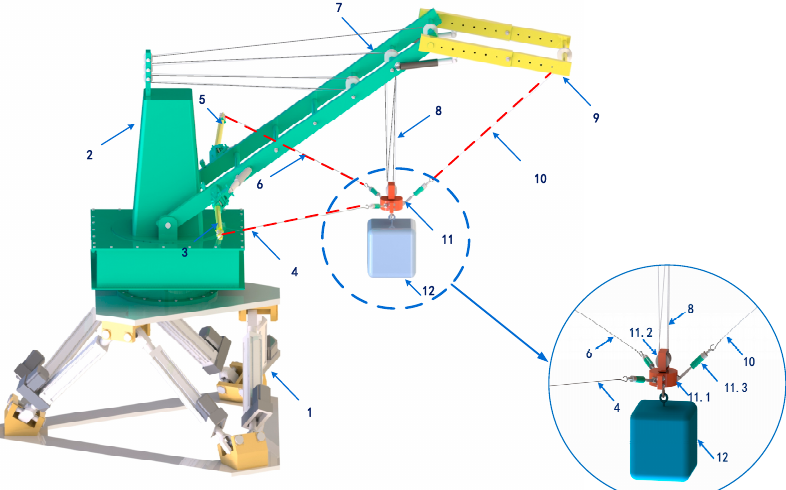
Figure 2. Three-dimensional schematic diagram of mechanical structure: 1—ship motion